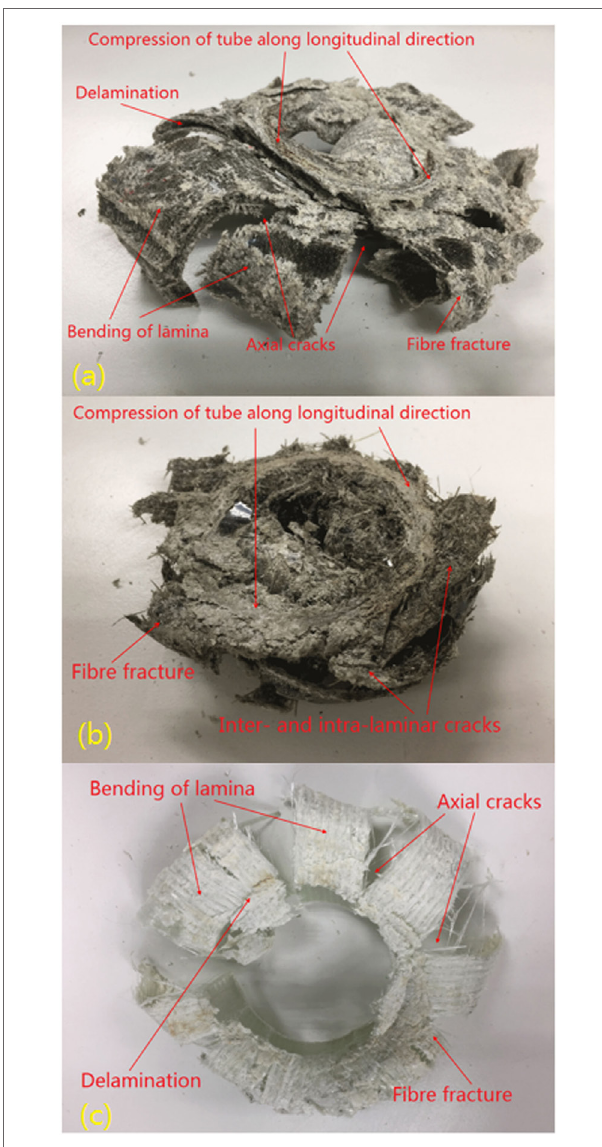
FigUre 12 | Typical failure modes of hollow fiber reinforced polymer tubes: (a) flax, (B) basalt, and (c) glass.